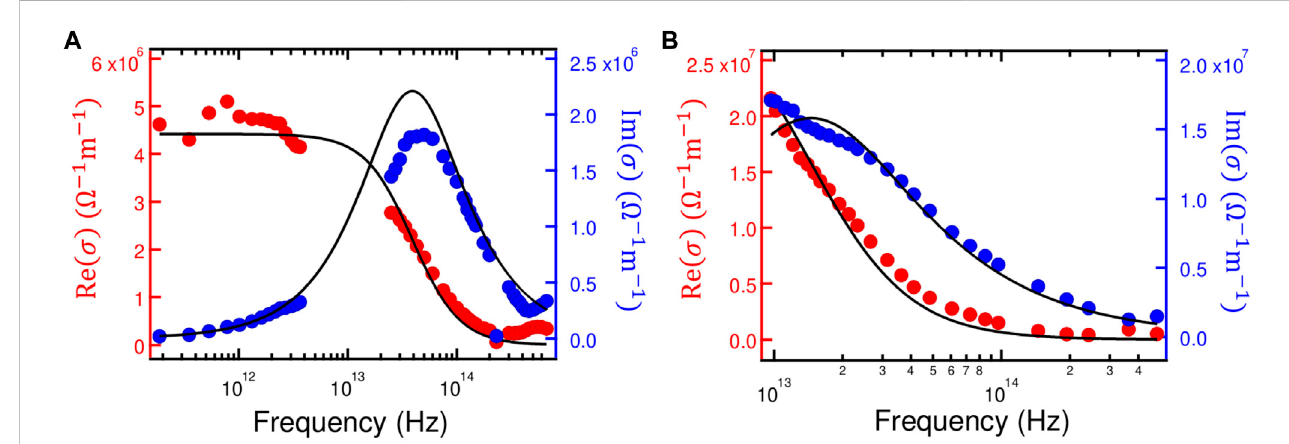
FIGURE 1 Drude fi ts to the optical conductivity of (A) lead (Pb) and (B) aluminum (Al) at room temperature. The real and imaginary parts of the conductivity are represented as red and blue markers, respectively. The Drude fi ts are shown as black solid lines. See text for the results. The raw data were obtained from (Golovashkin and Motulevich, 1968; Brändli and Sievers, 1972; Shiles et al., 1980; Ordal et al., 1983).